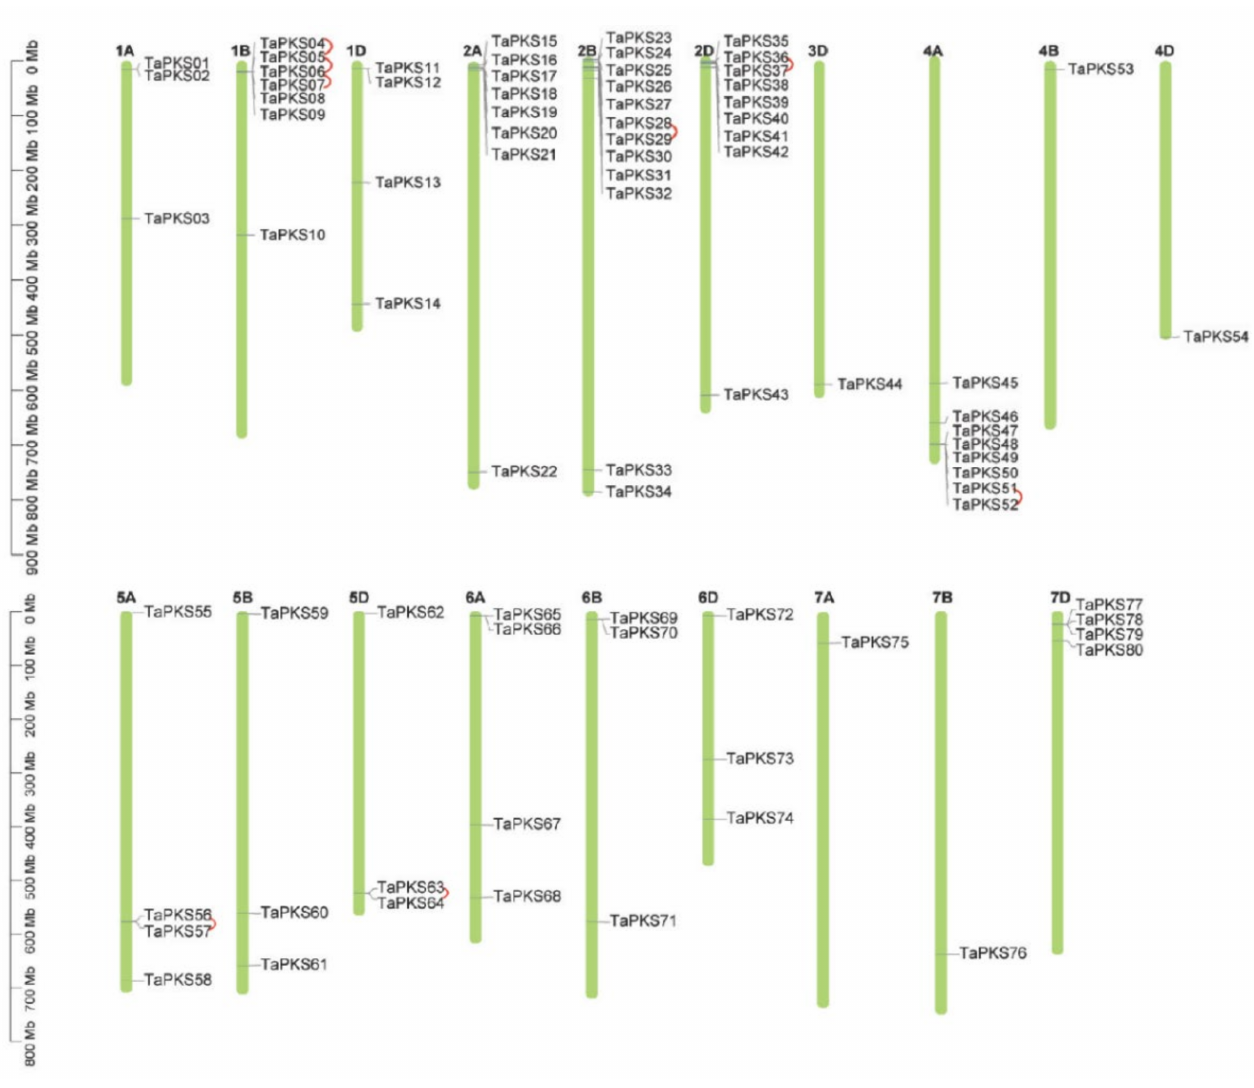
Figure 3. Chromosome locations of PKS family genes in wheat. Black font indicates tandem du- plication genes, which are connected by red arcs. The scale on the left indicates the length of the chromosome in millions of bases